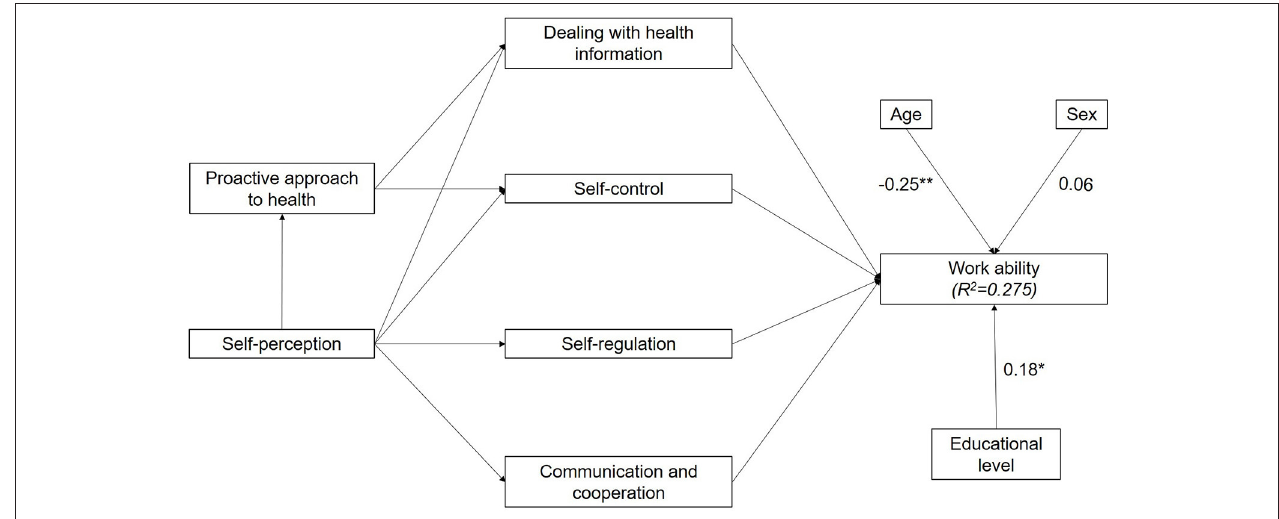
FIGURE 3 | Structural model of health literacy including sociodemographic context factors and work ability with determination coefficients ( R 2 ) and path coefficients. * p < 0.05, ** p <